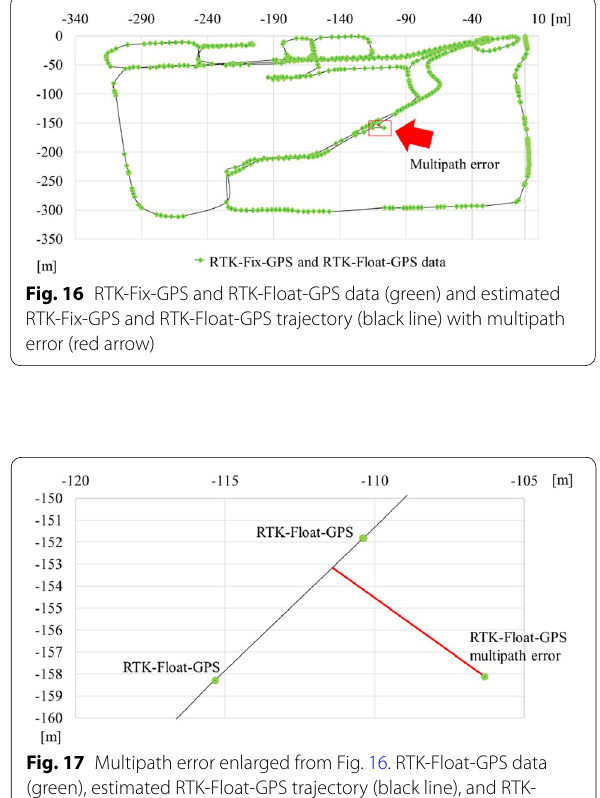
Fig. 18c. We used the Gauss-Kruger projection method calculation, which was also used by MMS to determine x–y coordinates based on GPS latitude and longitude.